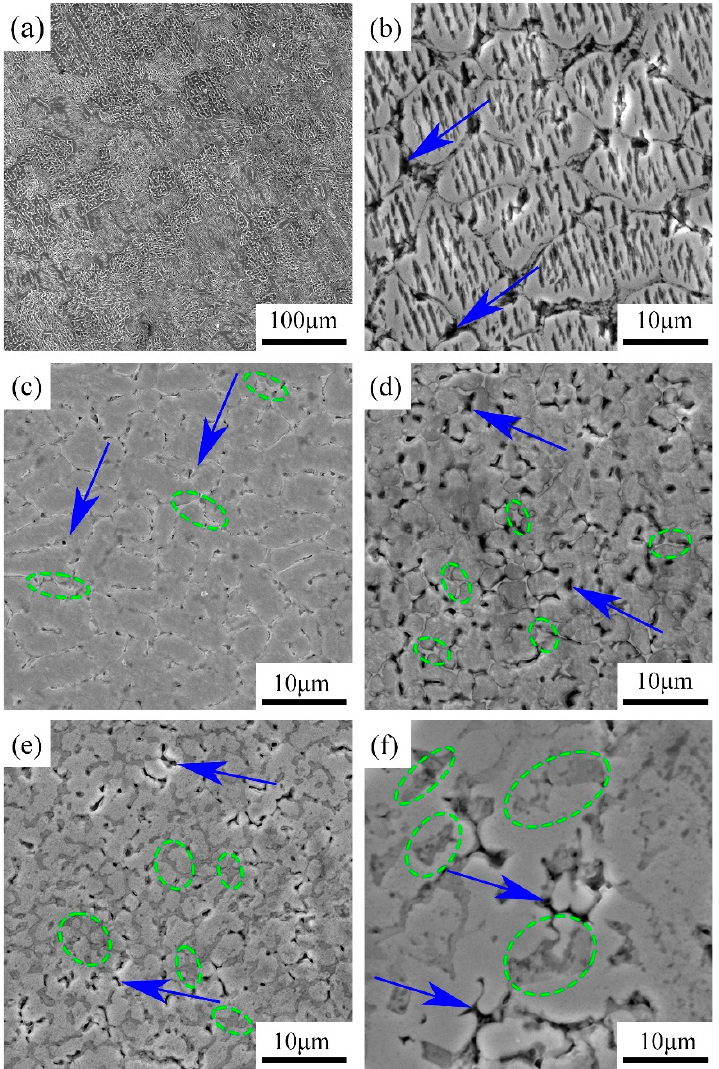
Figure 2. SEM images of rapid cooling Zr-Co(-Al) alloys microstructure: ( a ) Zr 50 Co 50 alloy; ( b ) Zr 48 Co 48 Al 4 alloy; ( c ) Zr 47.5 Co 47.5 Al 5 alloy; ( d ) Zr 47 Co 47 Al 6 alloy; ( e ) Zr 46.5 Co 46.5 Al 7 alloy; ( f ) Zr 46 Co 46 Al 8 alloy. The green circles indicate the secondary phase particles, and the blue arrows indicate the shrinkage cavity at the grain boundaries.